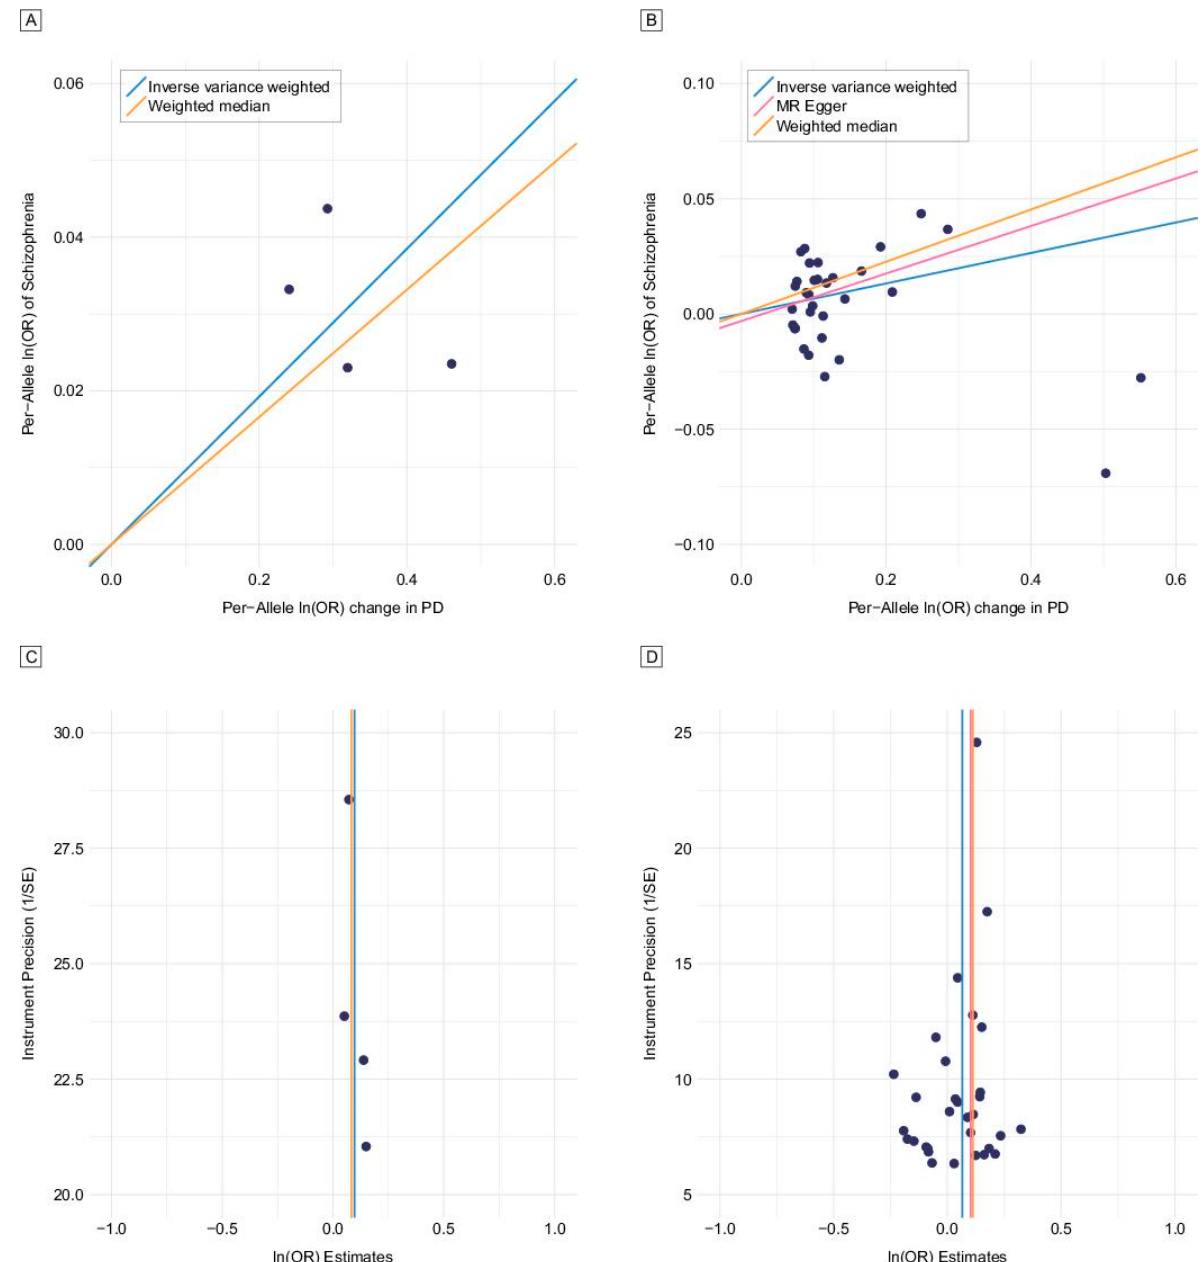
Figure 1. Mendelian randomization analysis for risk of Parkinson’s disease (PD) on schizophrenia using genetic instruments. ( A ) Schizophrenia associations (scatter plot) using four genetic instruments (PD) [24]. ( B ) Schizophrenia associations (scatter plot) using 32 genetic instruments (PD) [15]. ( C ) Precision (funnel plot) using four genetic instruments (PD) [24]. ( D ) Precision (funnel plot) using 32 genetic instruments (PD) [15].